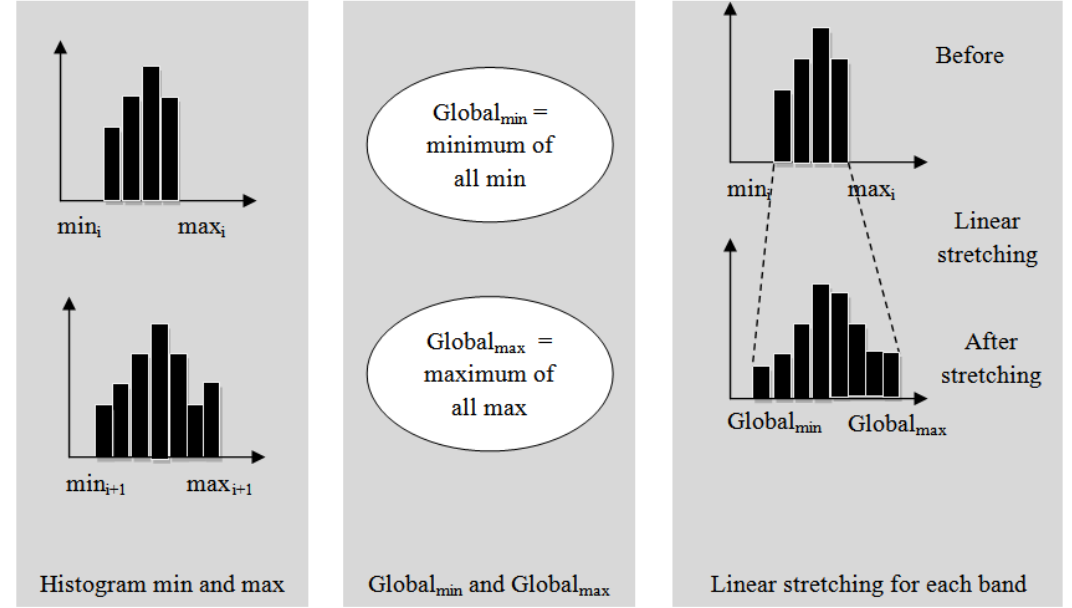
and Global diagram for histogram min max